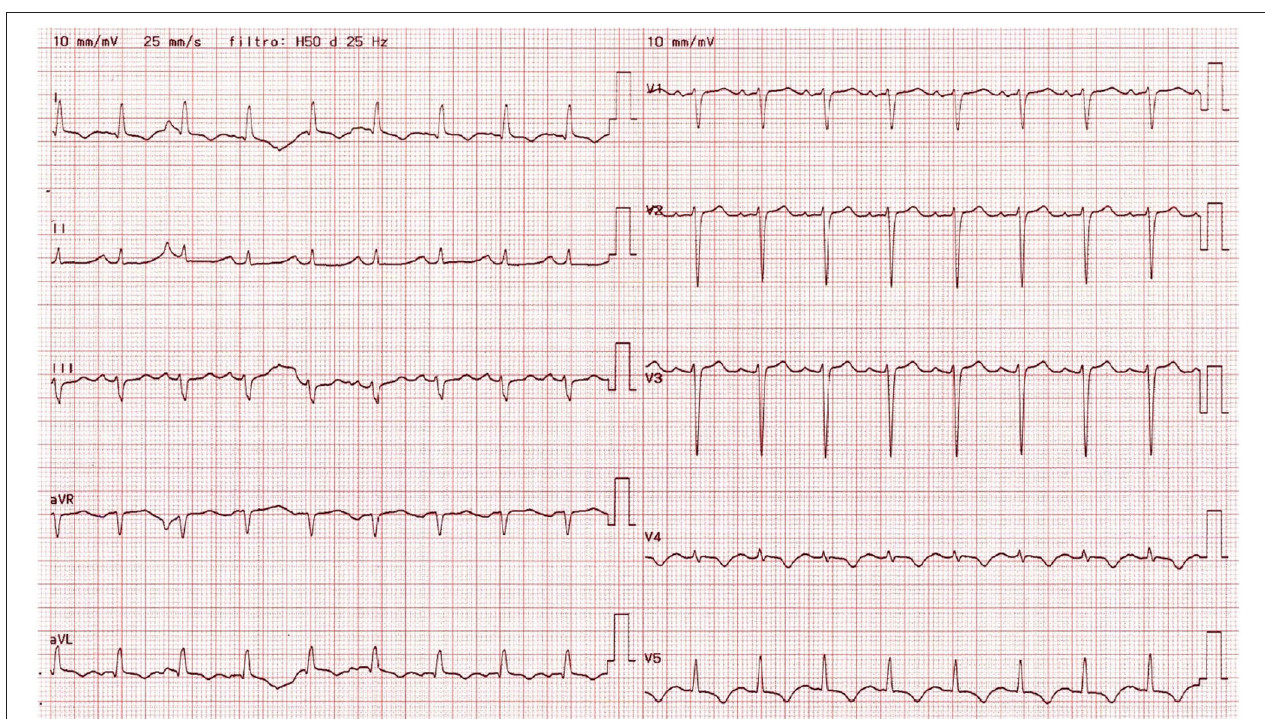
FIGURE 1 | 12-lead electrocardiogram obtained at admission, showing sinus tachycardia, T wave inversion in left precordial, inferior and lateral leads, and a prolonged corrected